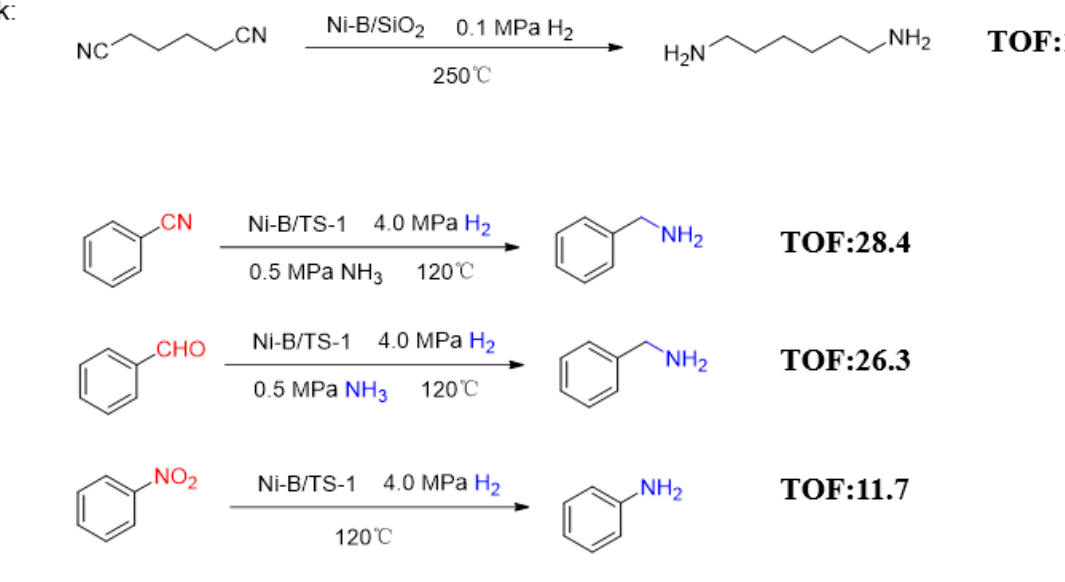
Table 1. Catalyst screening for benzonitrile a .